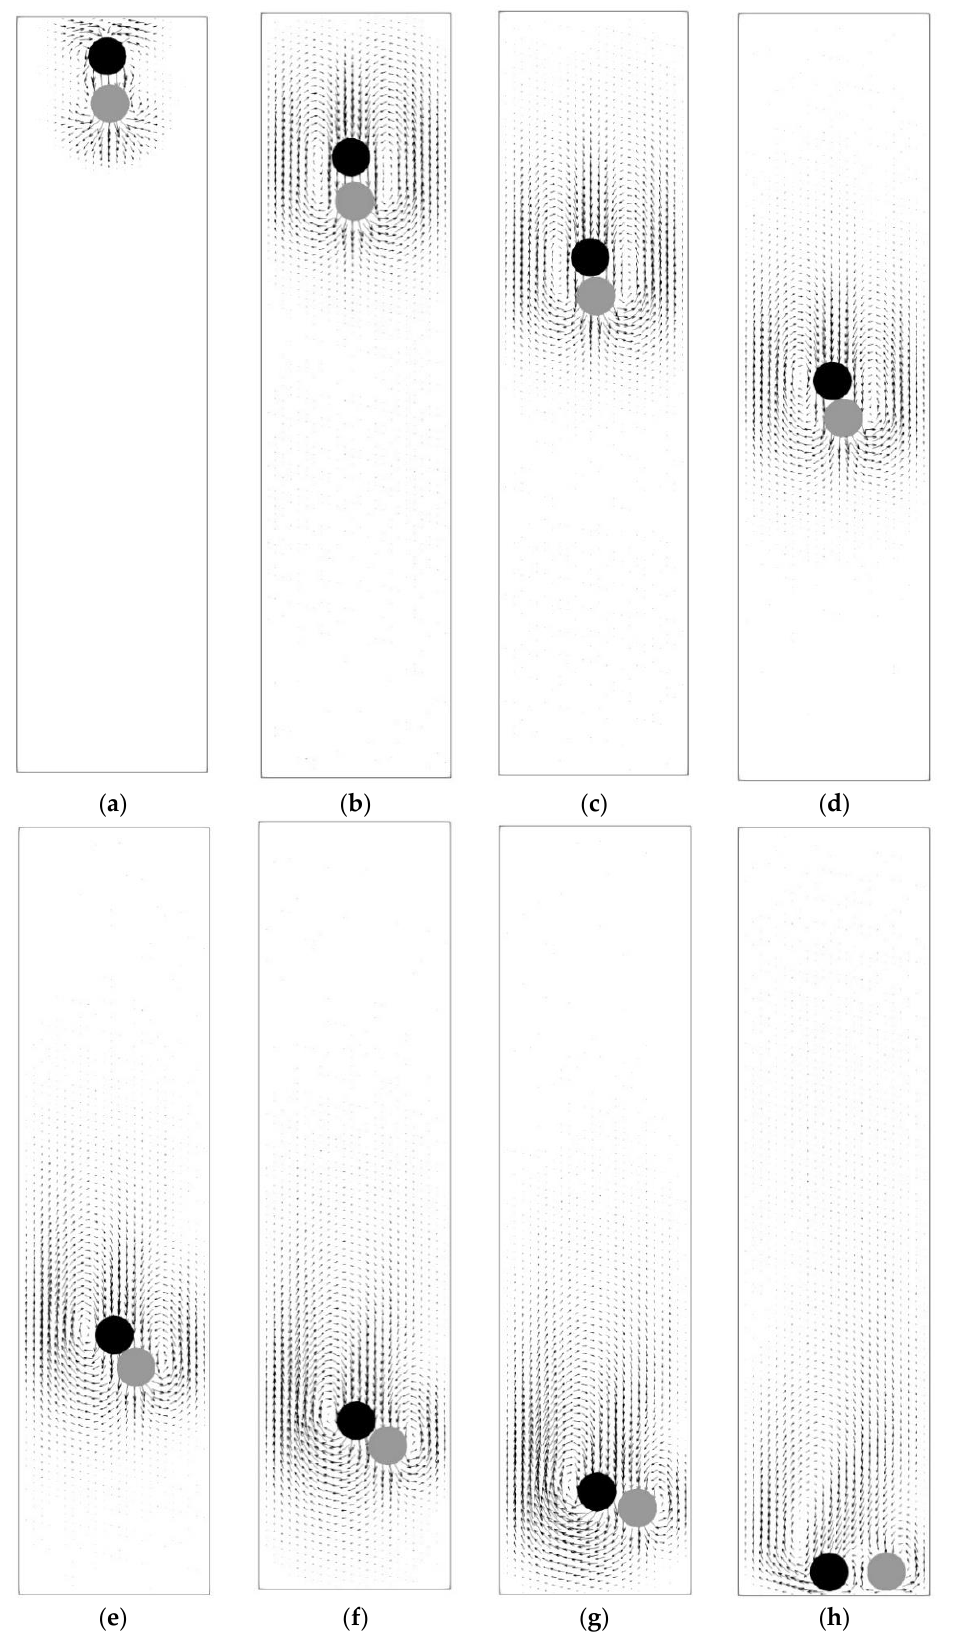
Figure 15. Two particles settling, drafting, kissing, and tumbling